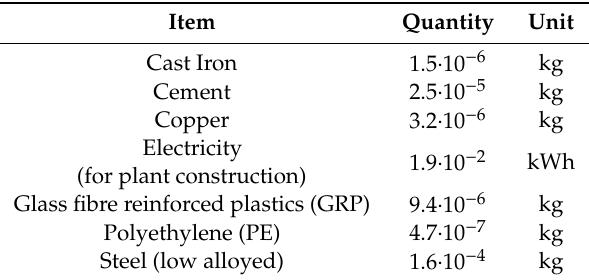
Table A3. Foreground inventory of life-cycle inputs for stream turbine tidal electricity generation. All values are per kWh of electricity generated.